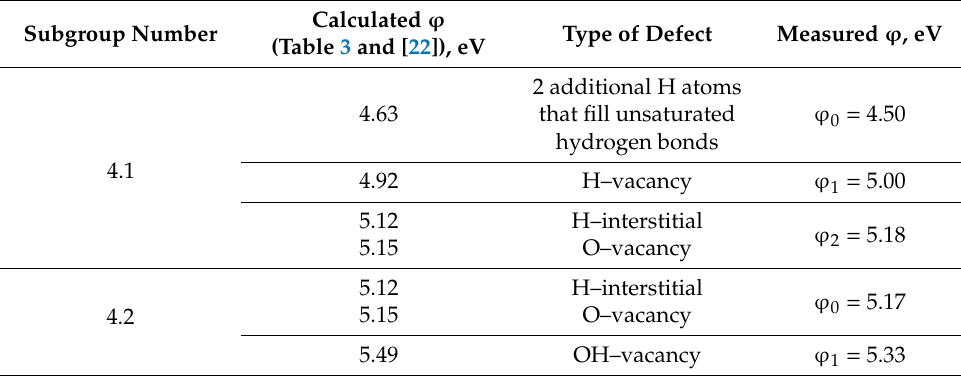
Table 11. Subgrouping of the samples of the group 4.